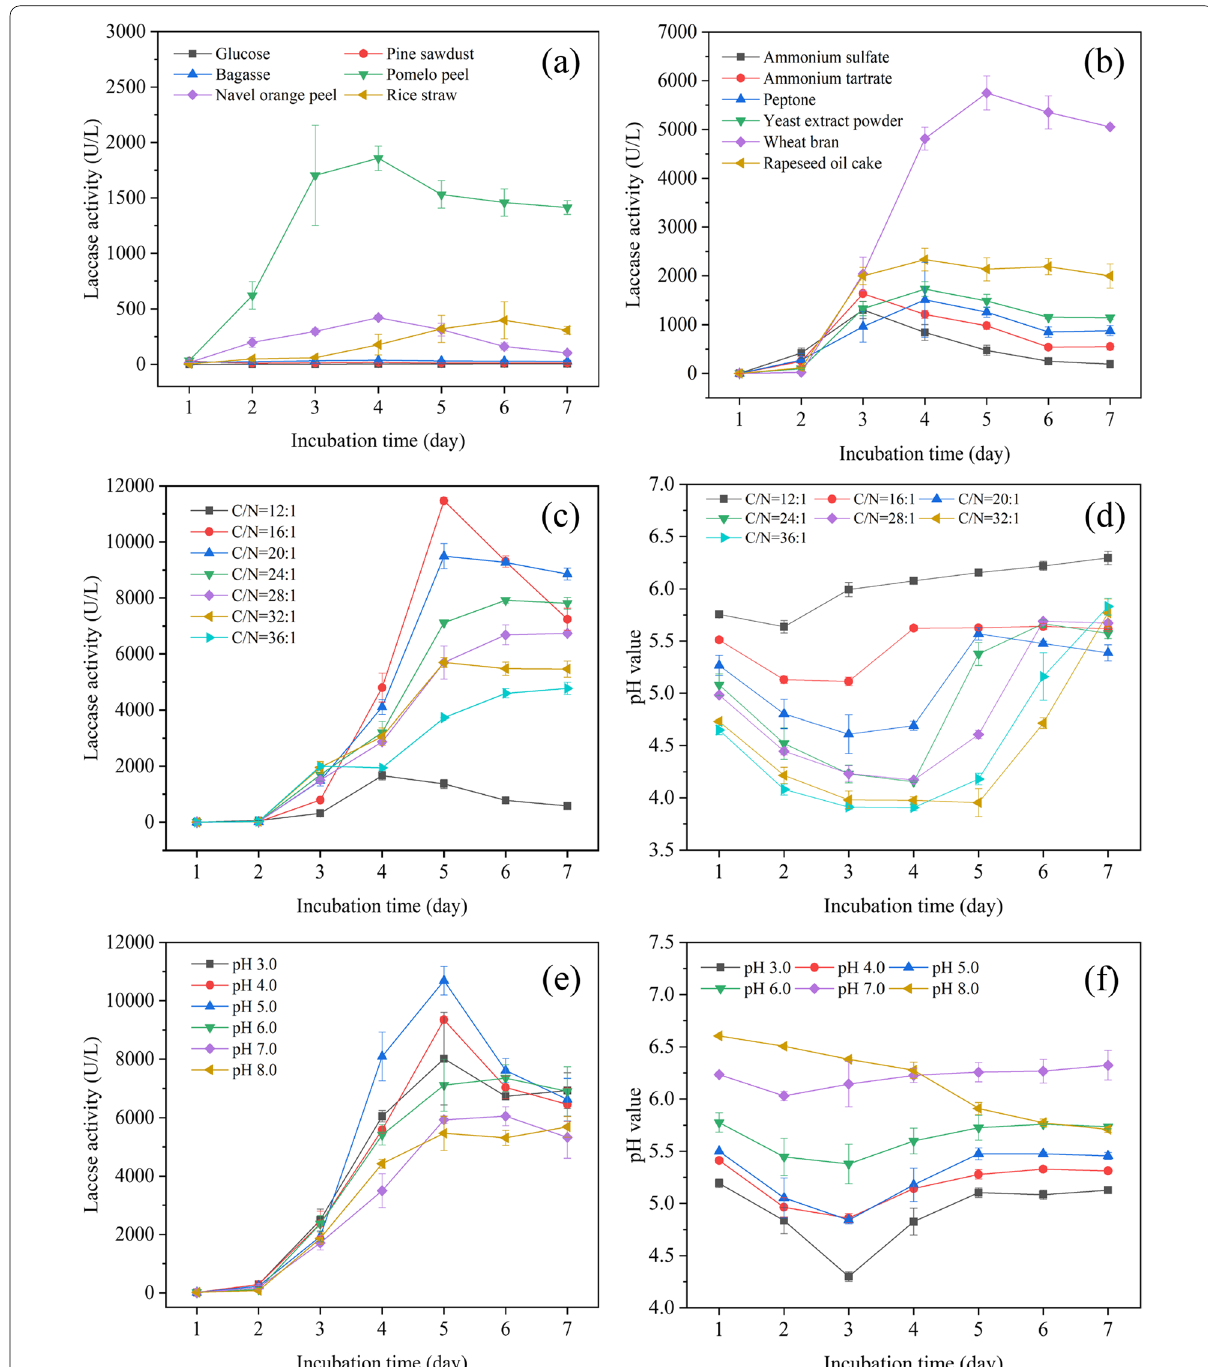
Fig. 1 Laccase production and pH variation in culture liquidunder different culture conditions. Effect of carbon source ( a ),nitrogen source ( b ) on laccase production. Effect of C/N ratio onlaccase production ( c ) and pH variation ( d ). Effect of theinitial pH on laccase production ( e ) and pH variation ( f